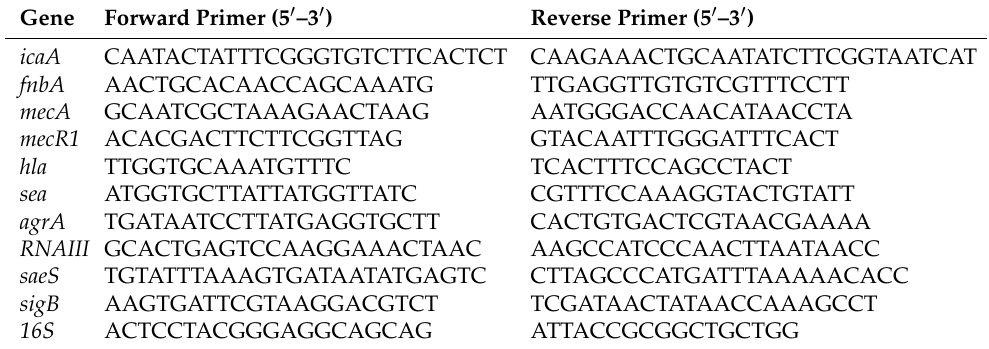
Table 2. Sequences of oligonucleotide primers designed for qRT-PCR. Gene Forward Primer (5 (cid:48) –3 (cid:48)